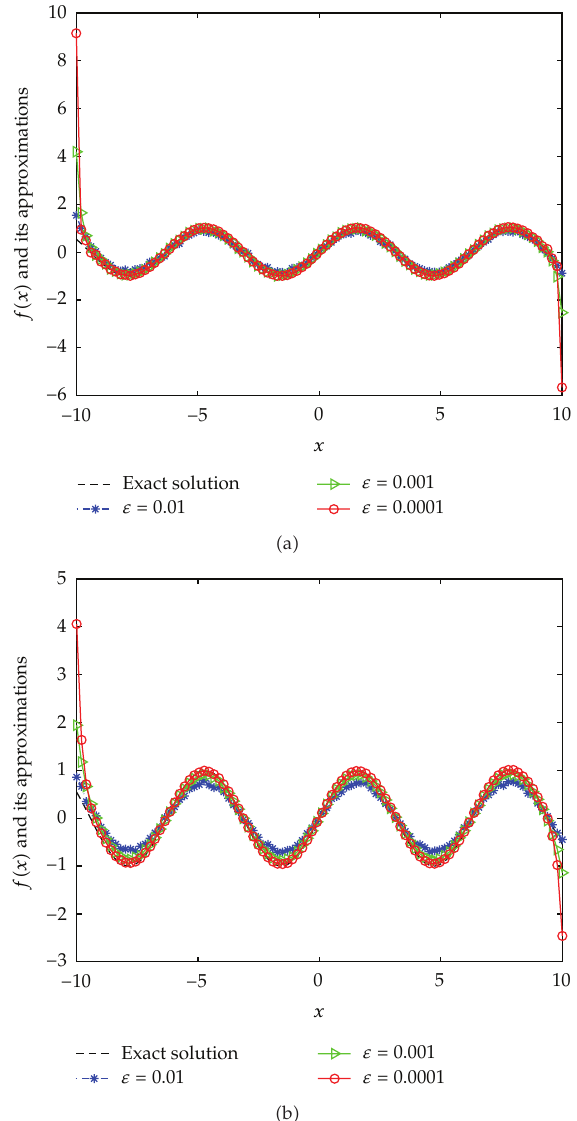
Figure 1: Comparison between the exact solution and its computed approximations with various levels of noise for Example 4.1: (cid:5) a (cid:6) p (cid:7) 1, (cid:5) b (cid:6) p (cid:7)